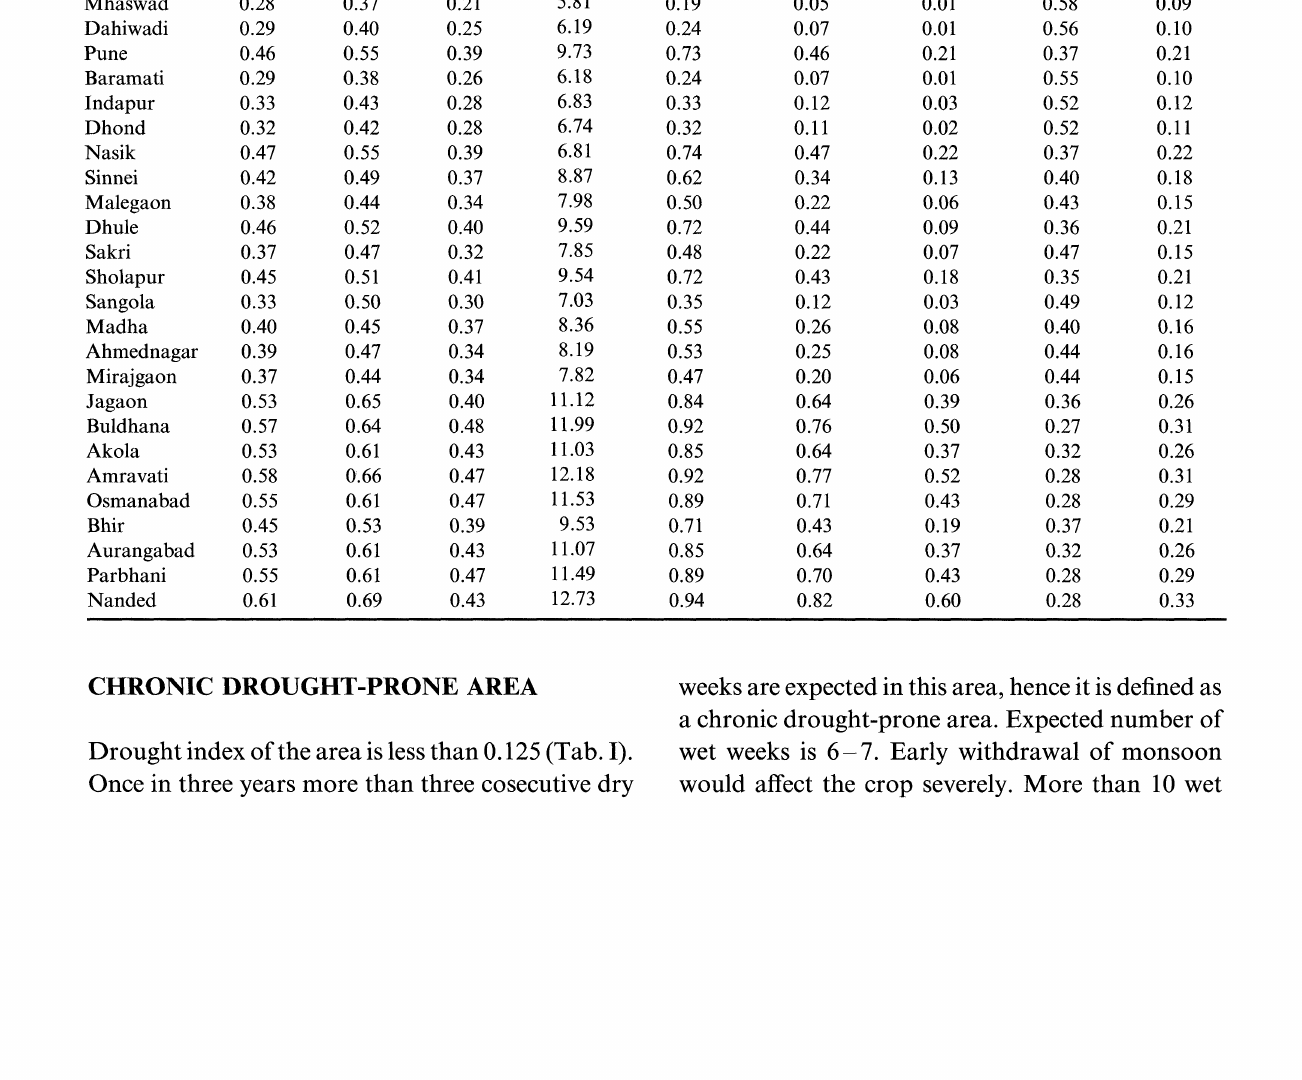
Probability of getting wet weeks at least